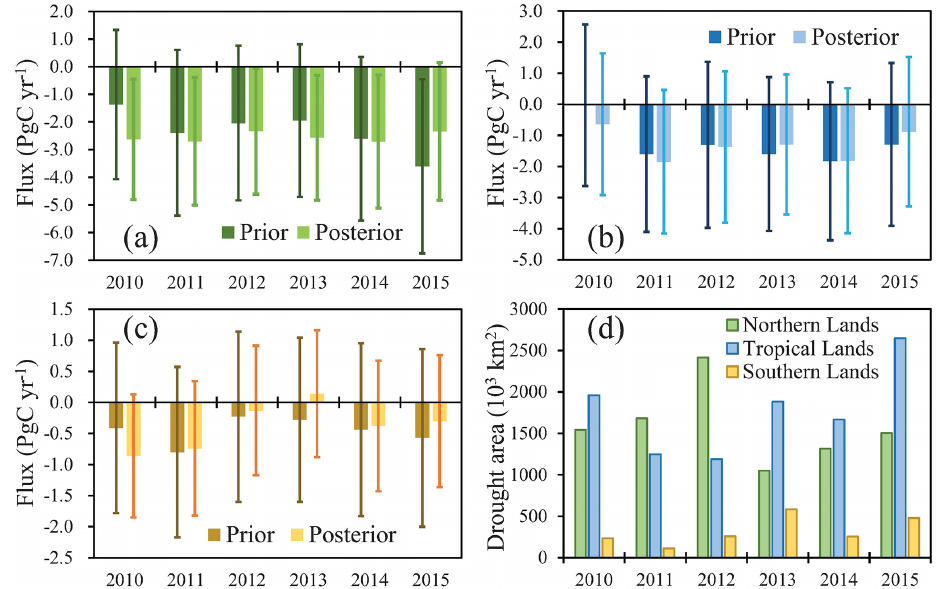
Figure 10. Prior and posterior interannual variations in the BIO fluxes in the (a) northern lands, (b) tropical lands, and (c) southern lands, respectively, and (d) severe drought areas of the abovementioned regions.